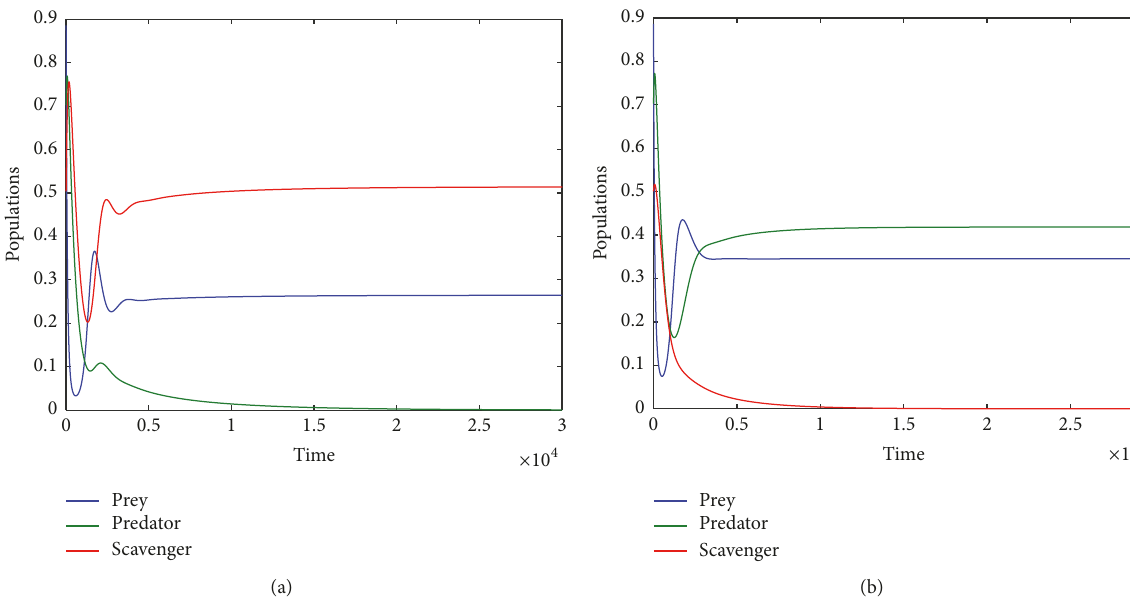
Figure 6: Time series for the solution of system (3) using data (76) with typical values of ] . (a) The system approaches 𝐸 3 = (0.26,0,0.51) for ] = 0.95 . (b) The system approaches 𝐸 = (0.34,0.42,0) for ] = 0.25 . 2